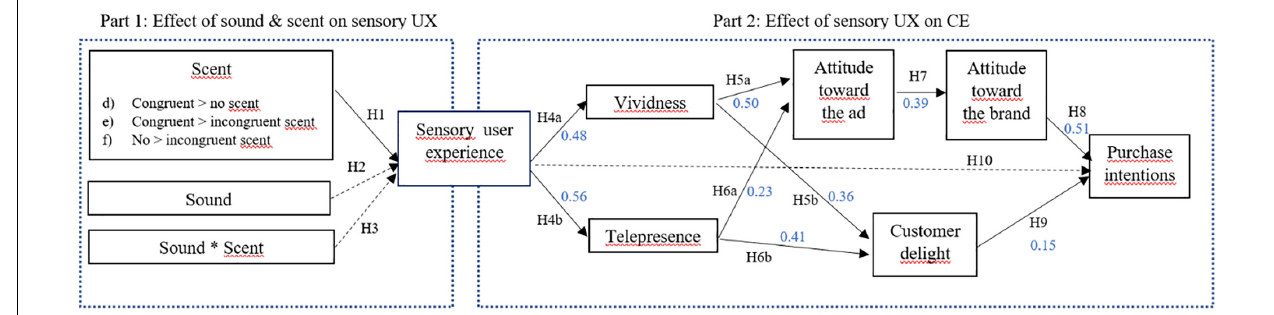
FIGURE 3 | Overview of the